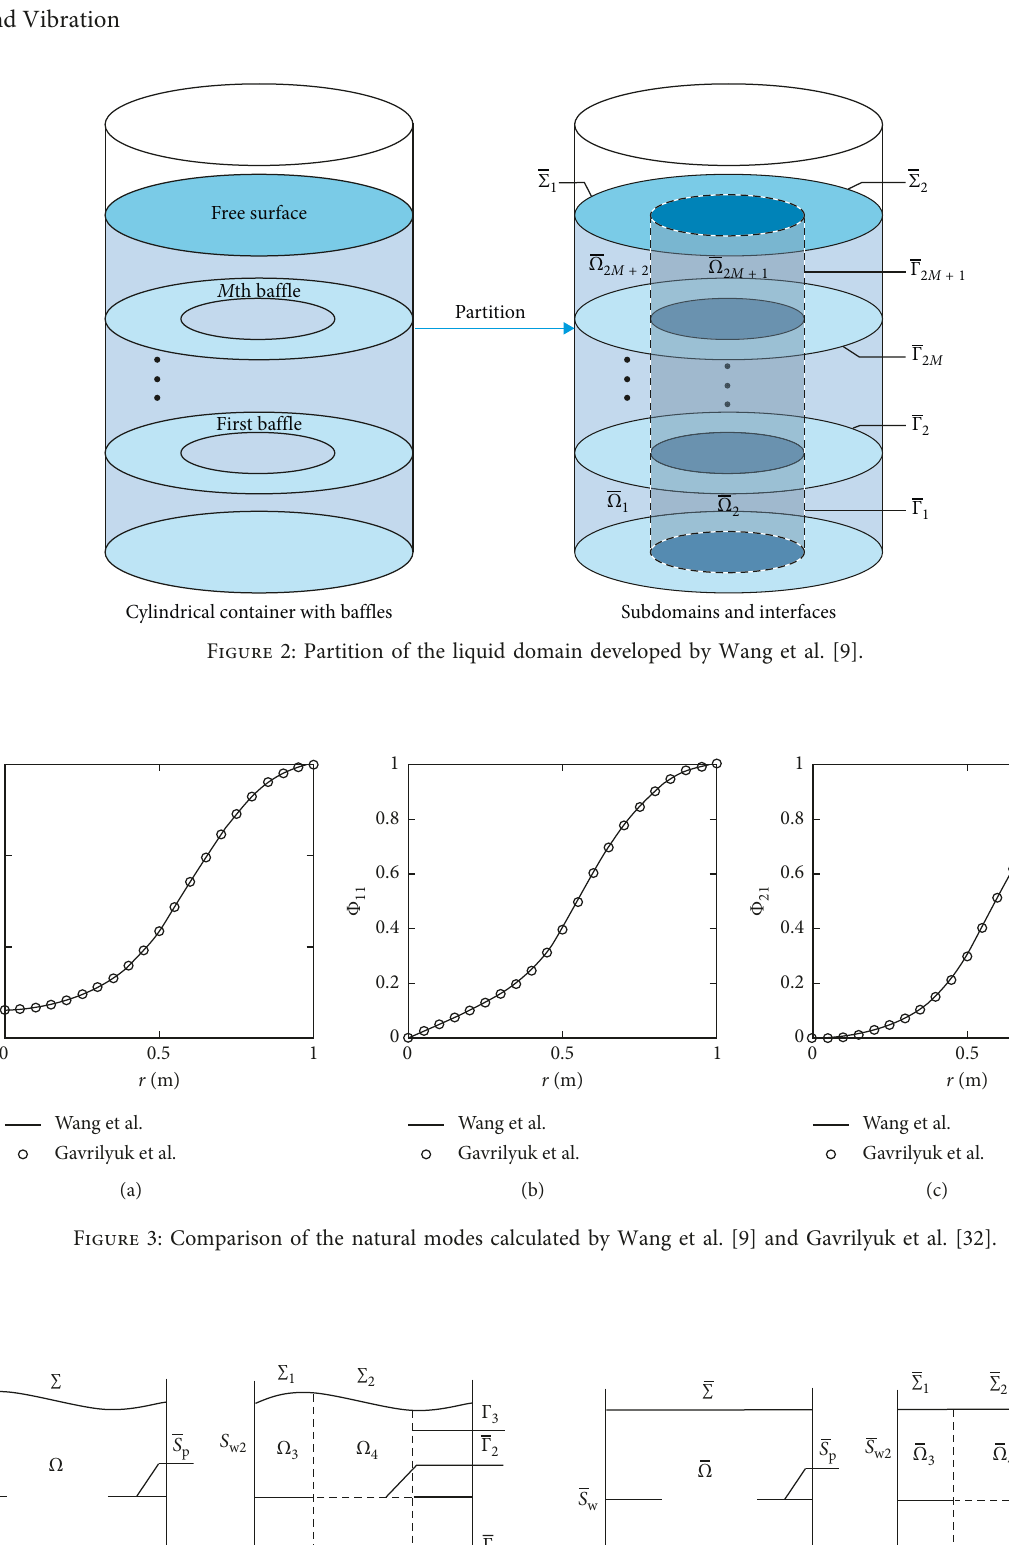
Figure 5: Cross section, subdomains, and artificial interfaces of the unperturbed liquid domain Ω